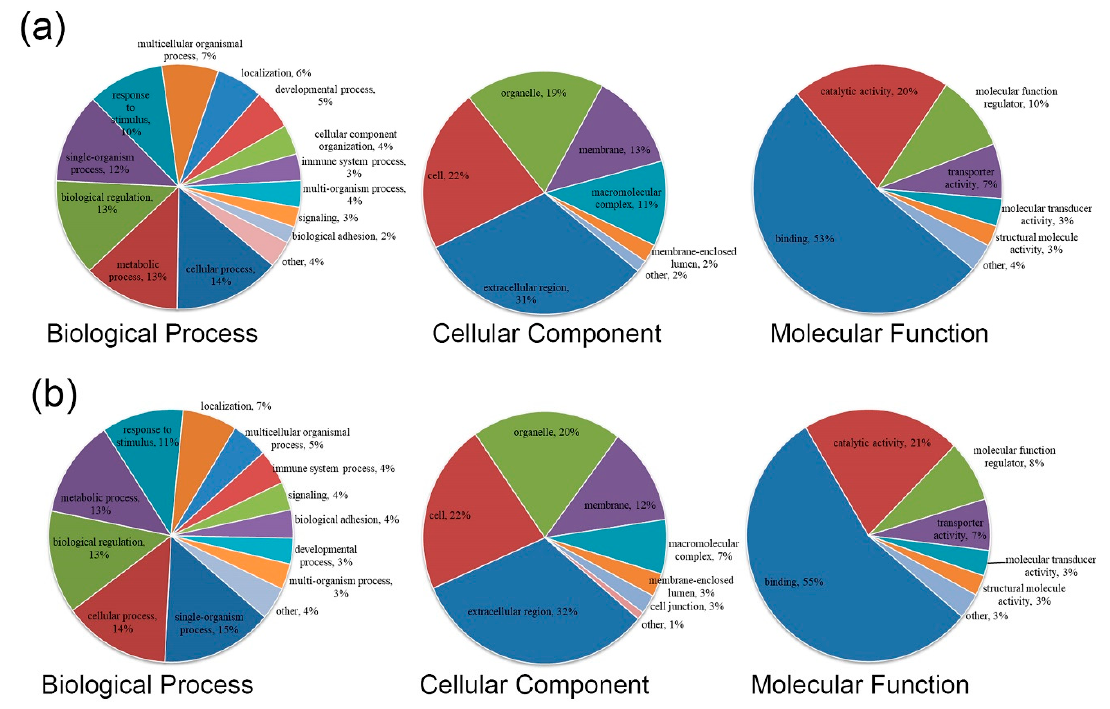
Figure 2. ( a ) Gene-ontology (GO) function annotation of PP vs. CC differential expression protein. ( b ) GO function annotation of PC vs. CC differential expression protein.